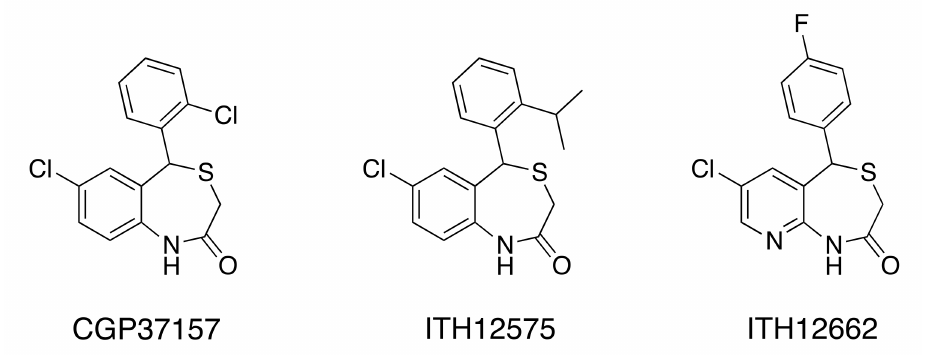
Figure 1. Chemical structures of the hit CGP37157 , and the leads ITH12575 [34,35] and ITH12662 [36,37], as the best compounds of the previously evaluated 4,1-benzothiazepines synthesized by our re- search